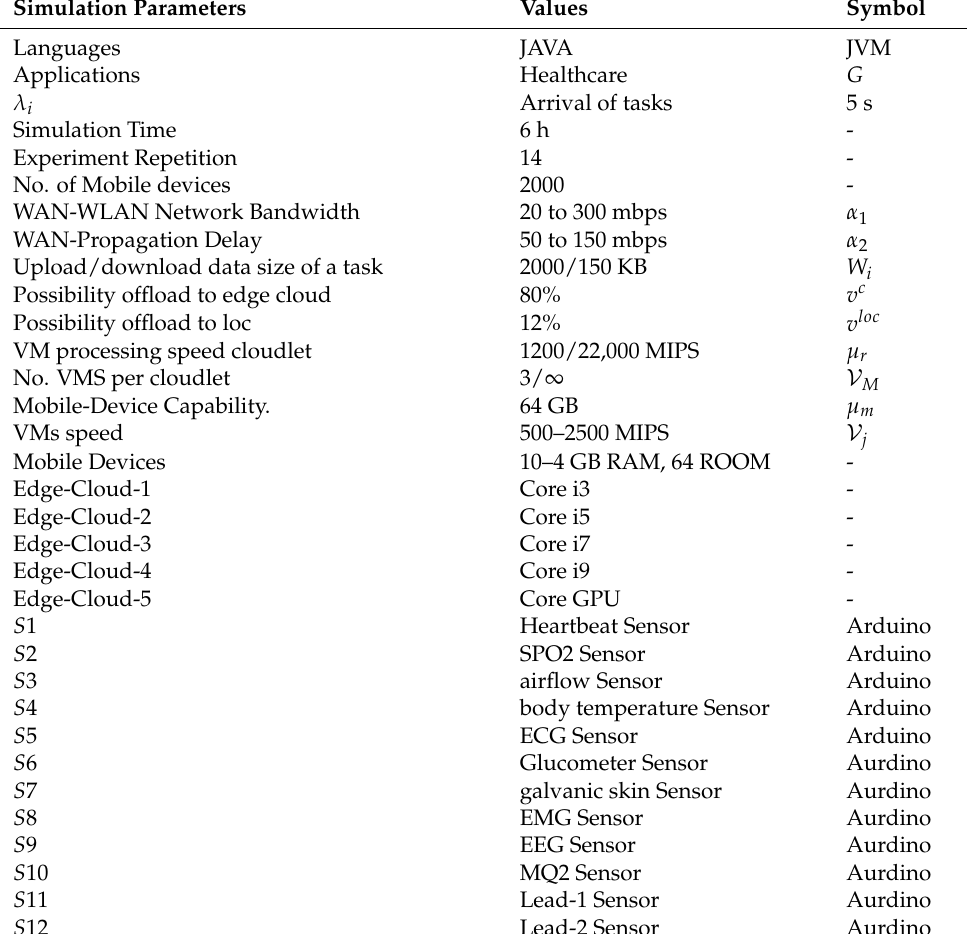
Table 2. Simulation